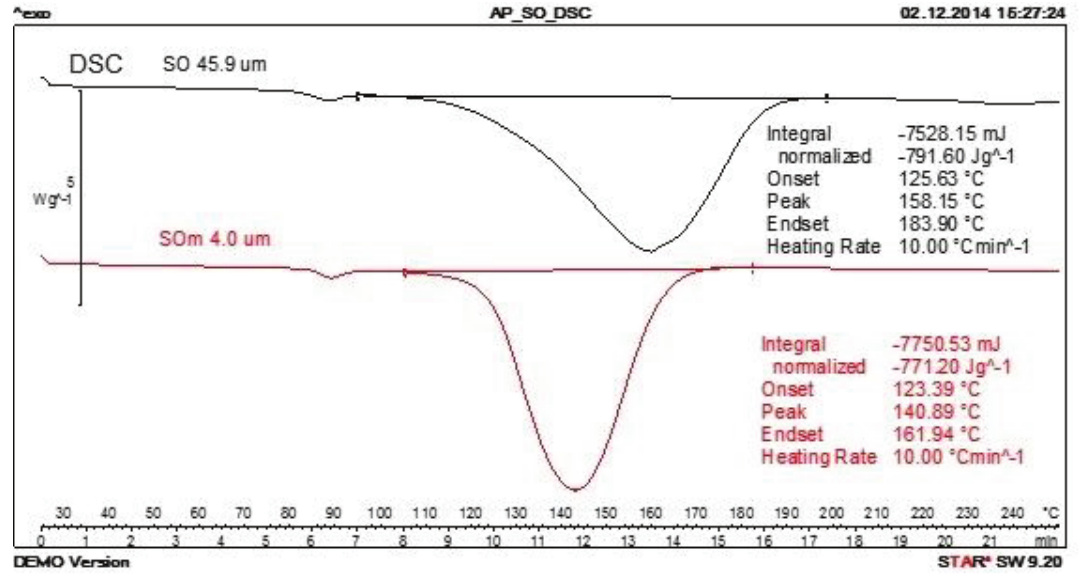
Fig. 4 – DSC analysis of sodium compounds SO and SOm